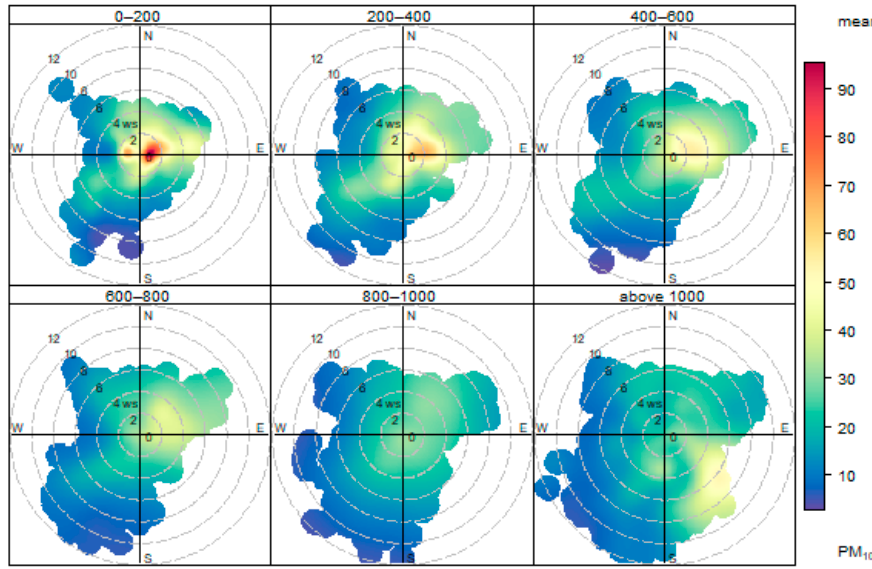
Figure 20. Average PM 10 concentration roses divided according to the mixing layer height, the V ěřň ovice site, 2016–2019.